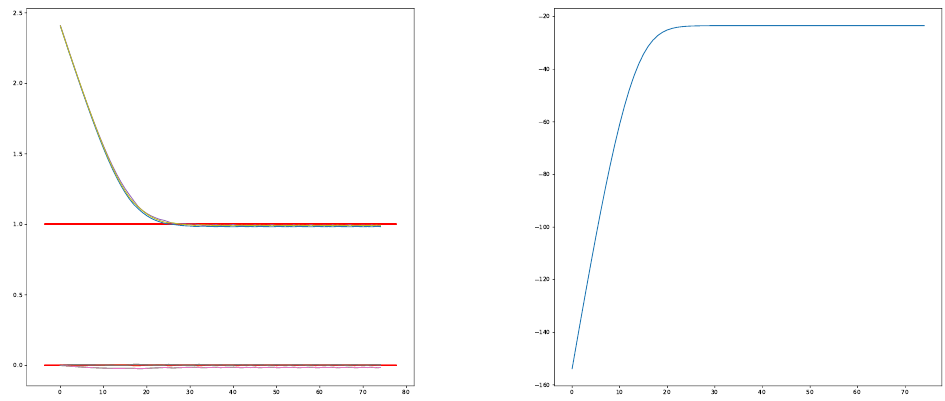
Figure 6. Given 256 data points in SPD ( 3 ) , we estimated the diffusion mean on the homogeneous space by sampling bridges in the top space conditioned on the fibers. The iterative MLE in Algorithm 1 yielded the convergence of the diffusion mean parameter, using a learning rate of 0.005 and one bridge sample per observation. ( Left ) The purple, blue, and yellow lines correspond to the diagonal of the metric matrix, whereas the remaining colors represent the off-diagonal. The true mean value is the identity matrix indicated by the red lines. ( Right ) The corresponding log-likelihood evolution through the